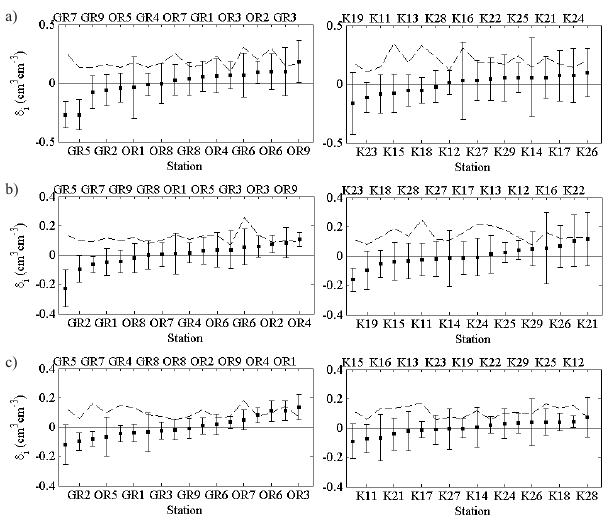
Fig. 9. Mean relative difference for the entire study period at the McMaster Mesonet sites at depths of (a) 10cm, (b) 20cm, (c) 50cm. GR and OR are grouped due to their close spatial proxim- ity, as are K1 and K2. The bars represent one standard deviation of the relative difference and the dotted line shows the RMSE from Eq. (9).